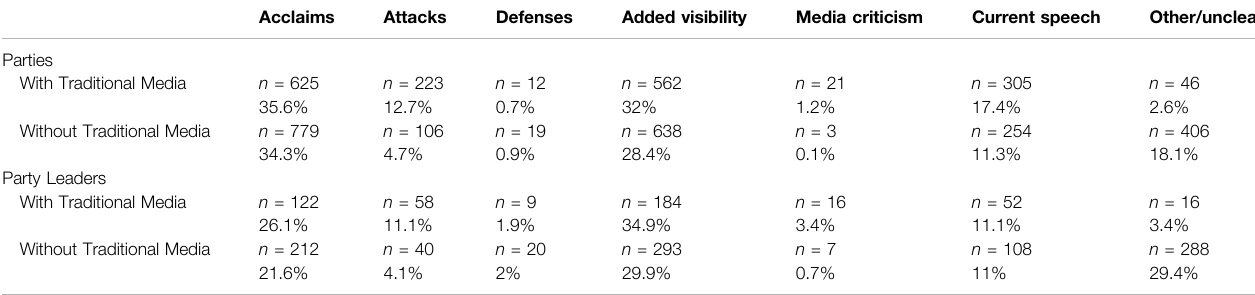
TABLE 6 | The functions of social media posts with and without traditional media